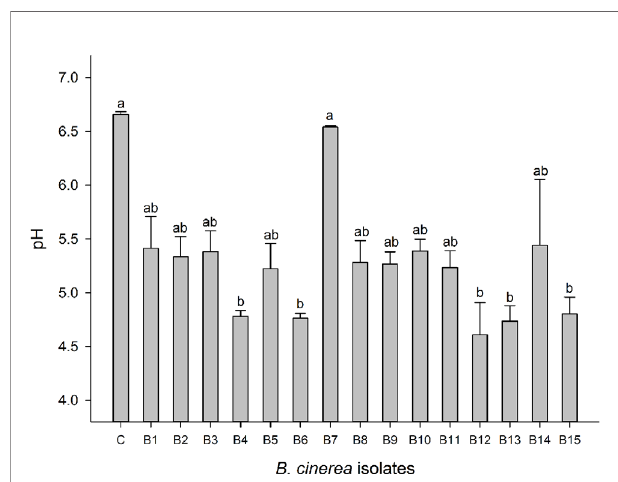
Leaves inoculated with the nonpathogenic strain B7 (A366) maintained the highest level of F v /F m and ChlIdx, while the